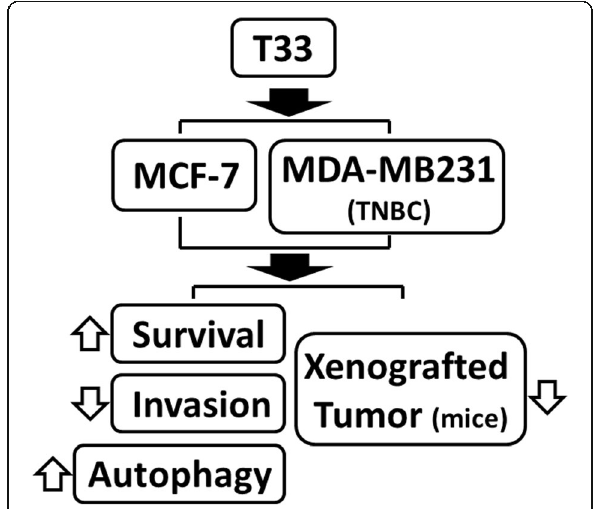
Fig. 6 In vitro and in vivo effects of T33 on breast cancer cells. T33 significantly inhibits the proliferation and invasive ability of MDA- MB231 and MCF-7 cells in vitro by inducing autophagy. T33 also significantly suppresses the growth of xenografted MDA-MB231 and MCF-7 cells in vivo. TNBC: triple-negative breast